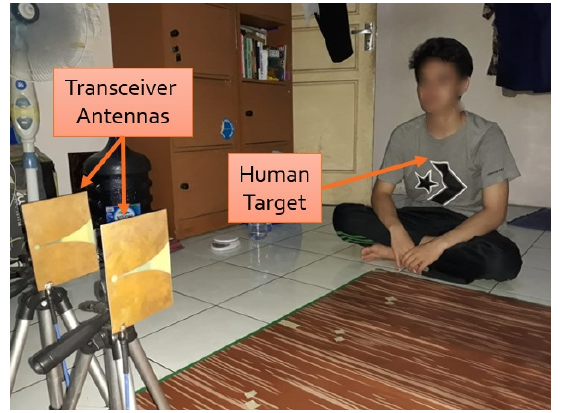
Figure 11. Experiment 2